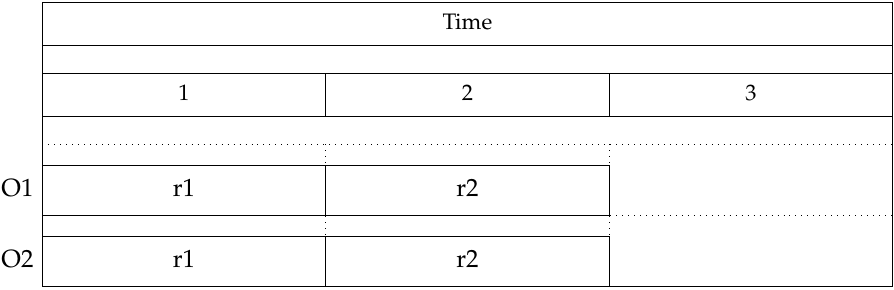
Figure 10. A Gantt diagram for the scenario from the second example. Activities marked as t in the row preceded by Ox denote involvement of the element x ( x is the unique identifier of a task element given at its first appearance or at the beginning of a scenario) during the activity t . Only elements that are active objects are included in the